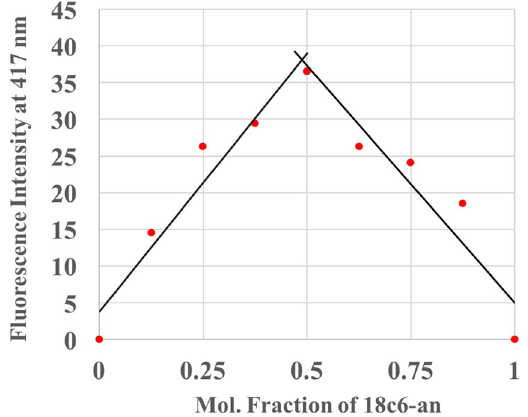
Figure 12. Job’s plot of 18c6-an and Ba2 + with total concentration of 40 µ M, which demonstrates a 1:1 binding